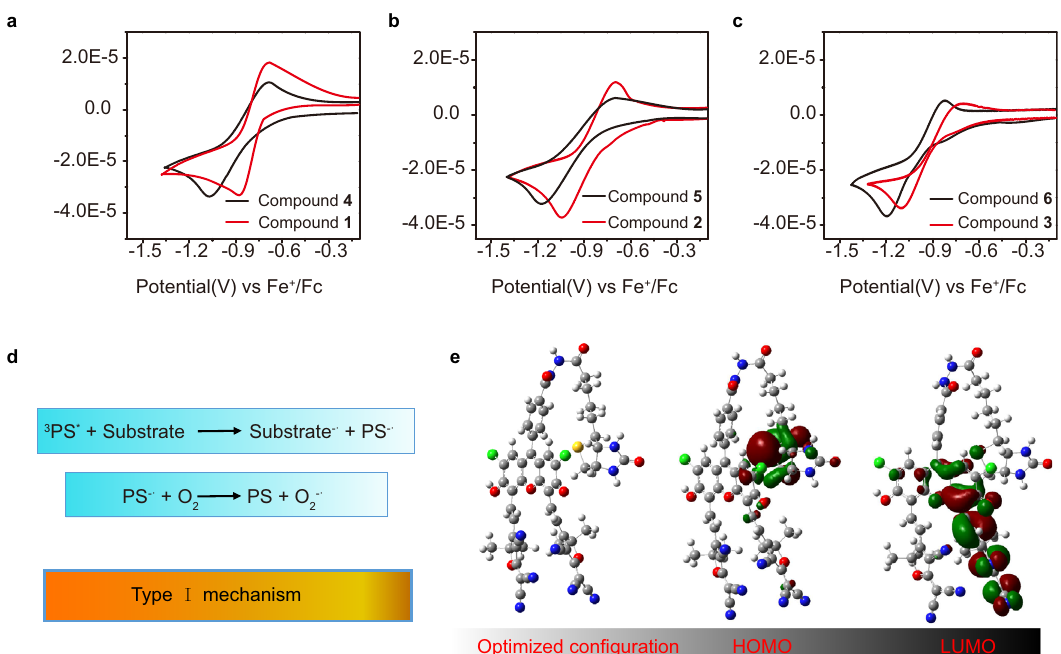
Fig. 7 The mechanistic explanation of the biotinylation effect. Cyclic voltammograms of a compound 1 , 4 , b 2 , 5 , and c 3 , 6 in DMF with 0.1 M (n-Bu) 4 N + PF − as a supporting electrolyte, glassy carbon as a working electrode, Ag/AgCl as a reference electrode, Pt wire as a counter electrode, and a scan rate 6 of 10 mVs − 1 . Fc/Fc + was used as an external reference. d Photochemical reactions during Type I mechanism ( 3 PS * represents the triple excited state of photosensitizer, PS − • represents the anion radicals of photosensitizer, 3 PS * is transformed into a radical anion by accepting electrons from